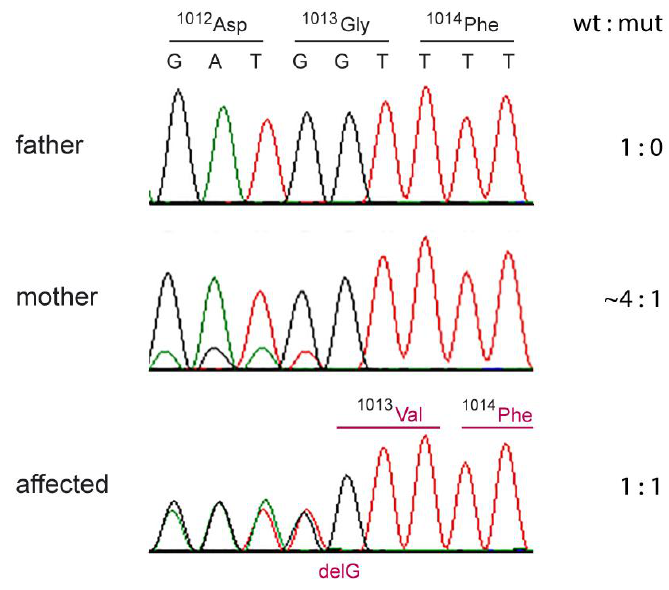
Figure 9. Sanger electropherograms illustrating the c.3038delG variant in case 1 and its parents. The sequence reads were obtained with a primer in reverse complementary orientation. While the affected dog shows a 1,1 ratio of the two alleles indicating a heterozygous genotype, the skewed allele ratio in the mother suggests somatic mosaicism. The mutant allele in the mother must have been present in white blood cells and her germline. This confirms that the c.3038delG variant arose by a de novo mutation event during the development of the mother.